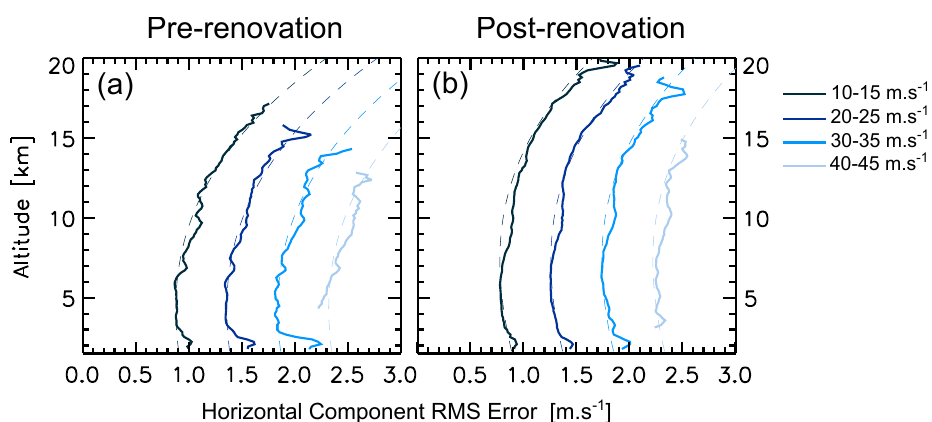
Figure 12. RMSE in horizontal wind components at different horizontal wind speeds. Curves show the combined error from beam separation (Fig. 10), and aspect sensitivity corrections (Fig. 8b) before and after the renovation (panels (a) and (b) , respectively). Different shaded curves correspond to the different horizontal wind speeds described in the legend. Pre-renovation and post-renovation curves use all wind directions in 2009 and 2012, respectively. The dashed lines are approximations of the solid lines, calculated with Eq. (A1a) in the Appendix.